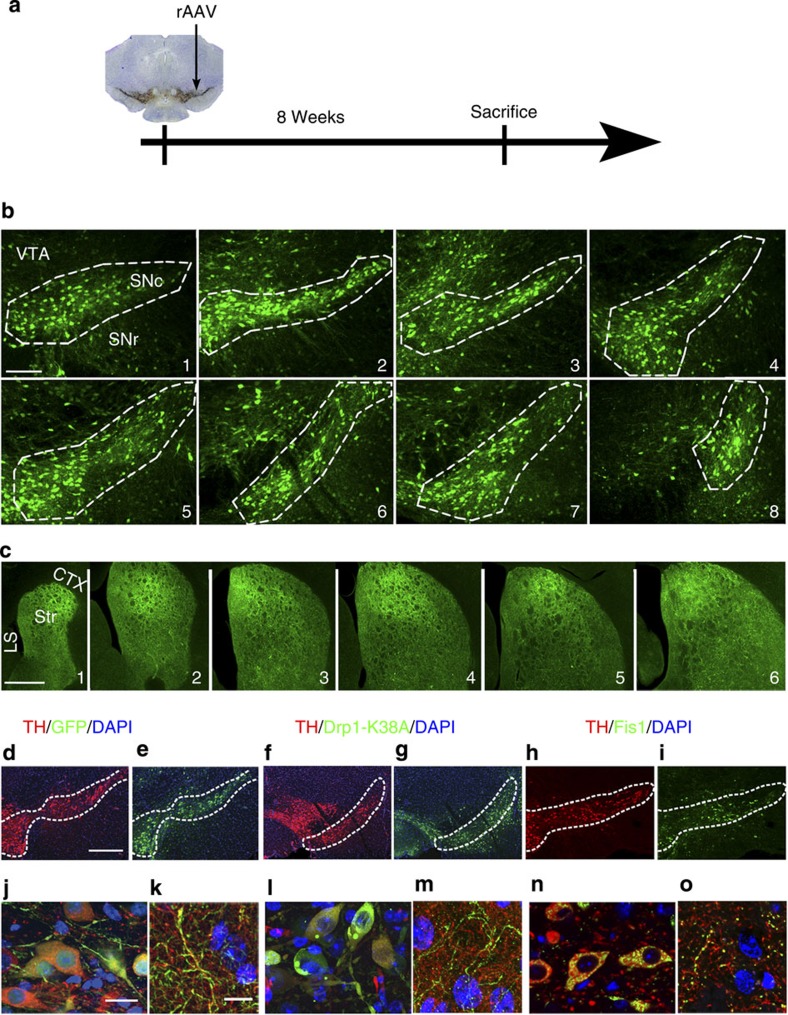
rAAV2-mediated gene expression in the nigrostriatal pathway.(a) Schematic illustrating stereotactic infusion of rAAV2 (5 × 109 viral particles) slightly dorsal to the substantia nigra pars compacta (SNc, arrows). (b) Expression pattern of GFP is illustrated in serial sections of SNc from its most rostral (b1) to caudal (b8) boundaries after 8 weeks of rAAV2-eGFP gene delivery. (c) Levels of rAAV2-mediated GFP expression in nigral axonal projections throughout the rostral (c1) to caudal (c6) extent of the striatum, and in adjacent brain structures such as the cortex (CTX) and lateral septum (LS). Immunofluorescent signals of Drp1-K38A (a dominant negative mutant of Drp1), Fis1 and GFP control in nigral DA cell bodies (e,g,i,j,l,n) and their striatal terminals (k,m,o) 8 weeks after supranigral stereotactic delivery of 5 × 109 rAAV2 particles. Scale bars (b1–b8), 400 μm, (c1–c6) 1 mm, (d–i) 400 μm, (j,l,n) 20 μm, (k,m,o) 10 μm.